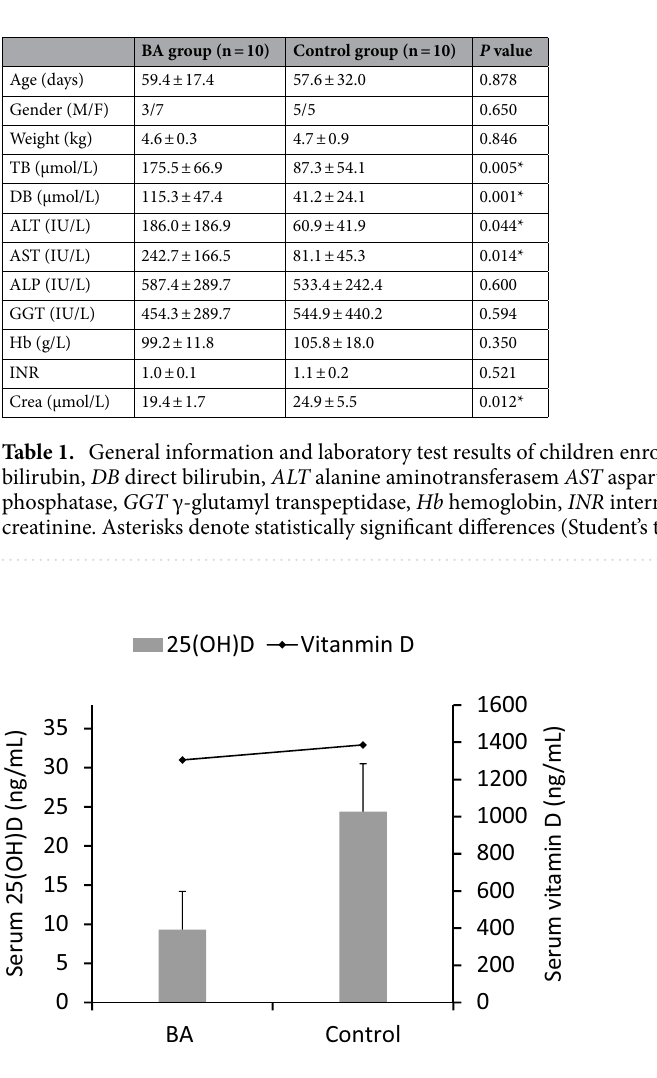
Figure 1. Serum levels of vitamin D in the BA and control groups were similar, while 25(OH)D level in the BA group was significantly lower than in the control group, thus, suggesting that conversion of vitamin D to 25(OH) D was impaired in children with